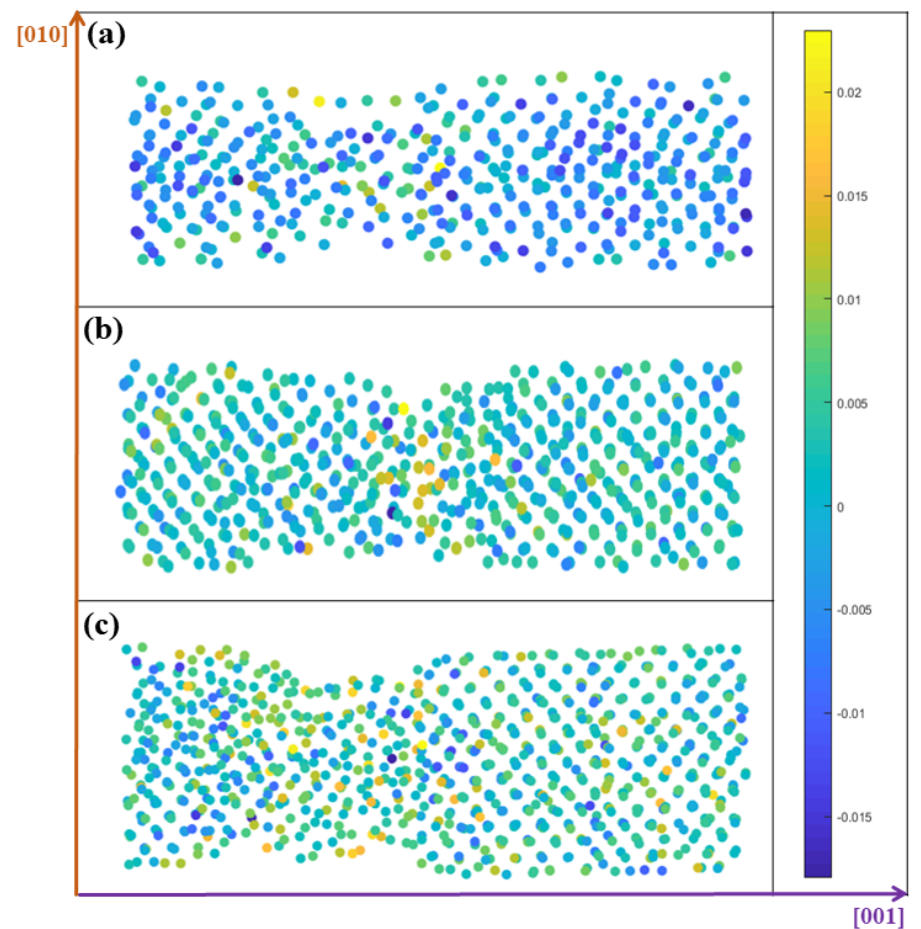
Figure 8. The isotropic atomic pressure in the three Si nanowires at σ b : ( a ) SiNW1, ( b ) SiNW2, ( c ) SiNW3.